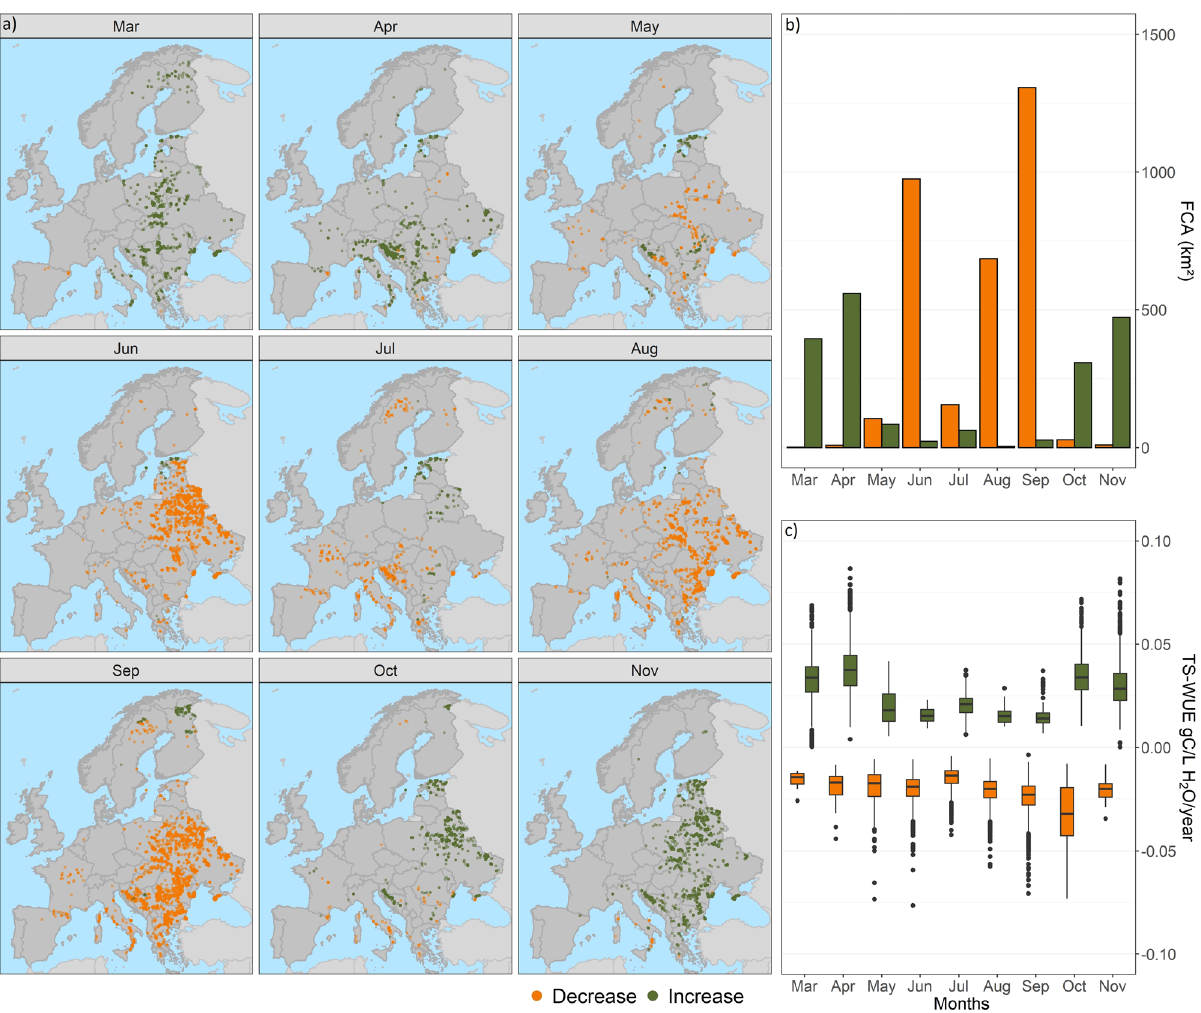
Fig. 4 Spatial and temporal dynamics of water-use-ef fi ciency over undisturbed forest core areas from 2000 to 2020. a Distributions of forest core areas (FCAs) with statistically signi fi cant ( p < 0.05) increasing or decreasing trends for monthly-scale water-use ef fi ciency (WUE) from 2000 to 2020. b Total area of FCAs with signi fi cant increases or decreases in WUE. c Theil – Sen ’ s slope (TS) values for increasing and decreasing WUE trends at monthly